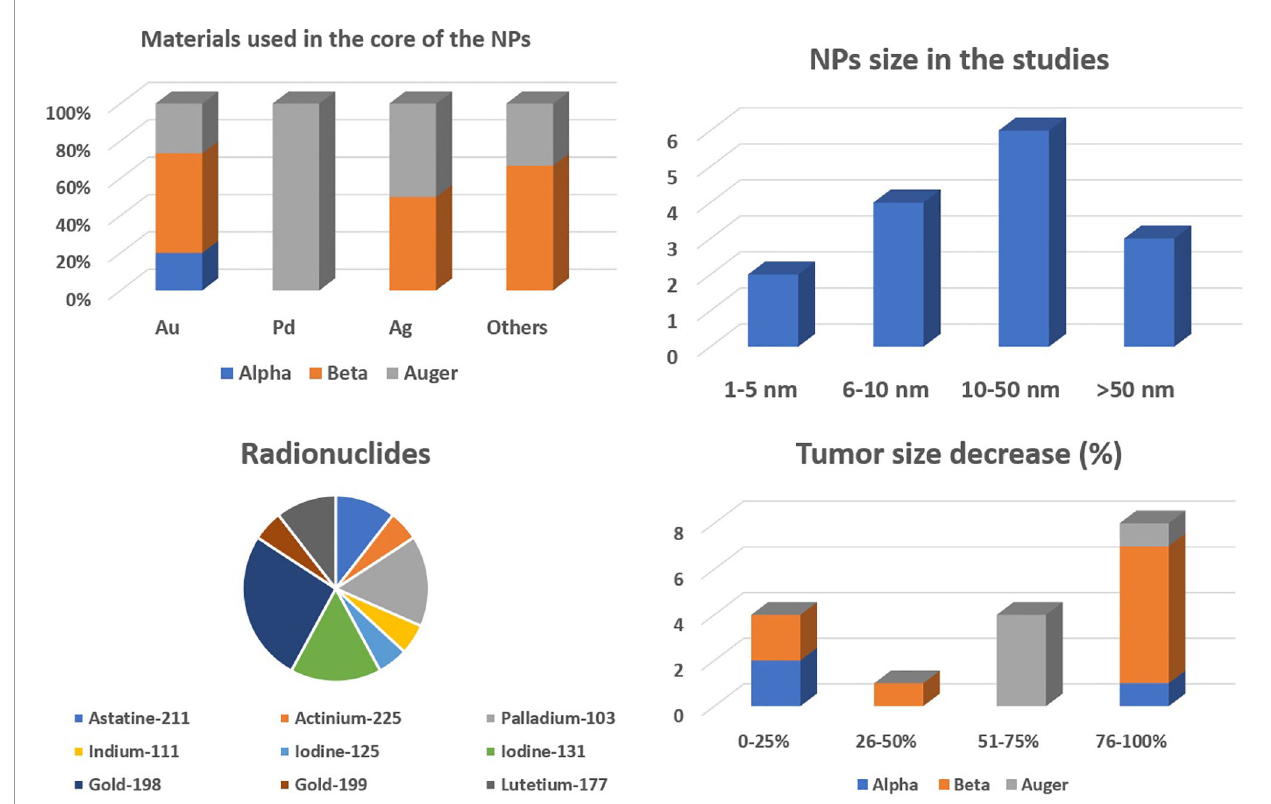
FIGURE 4 | Summary of the main fi ndings from the preclinical